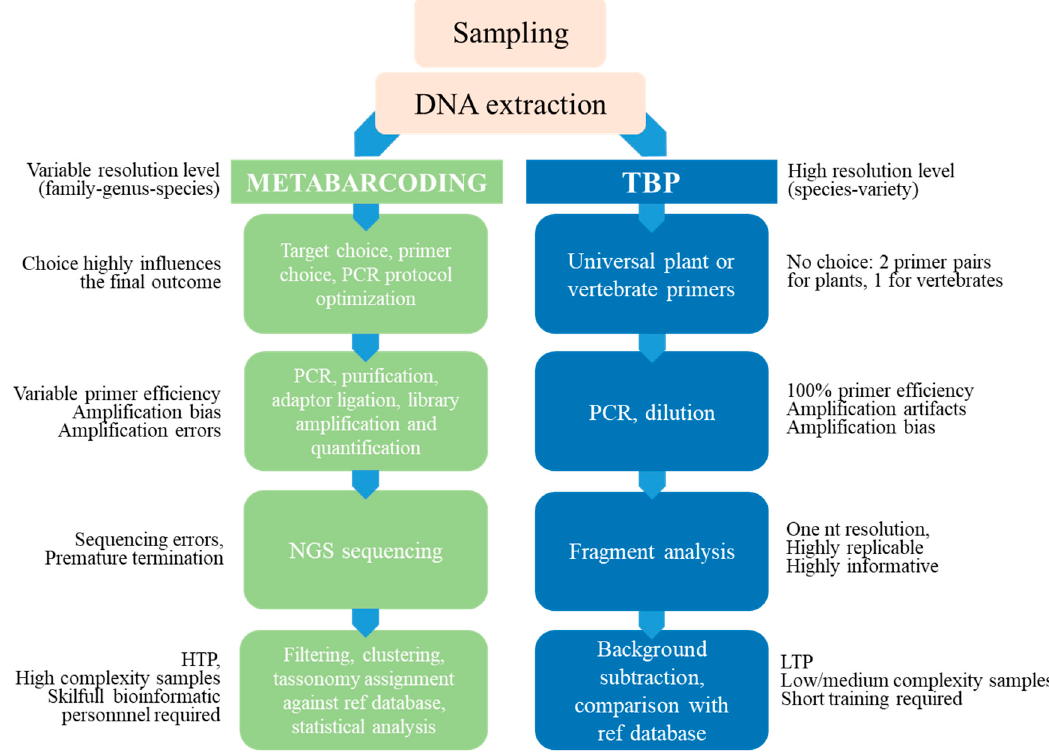
Figure 5. Comparison of barcoding and TBP workflows. Summary of the strength and the weakness of the classical metabarcoding method compared with TBP fingerprinting.